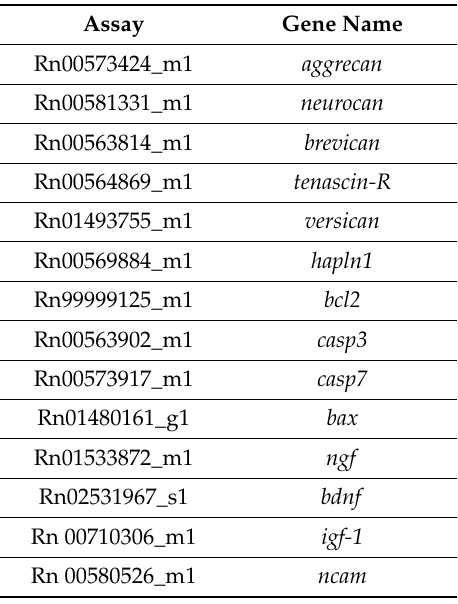
Table A4. Gene expression